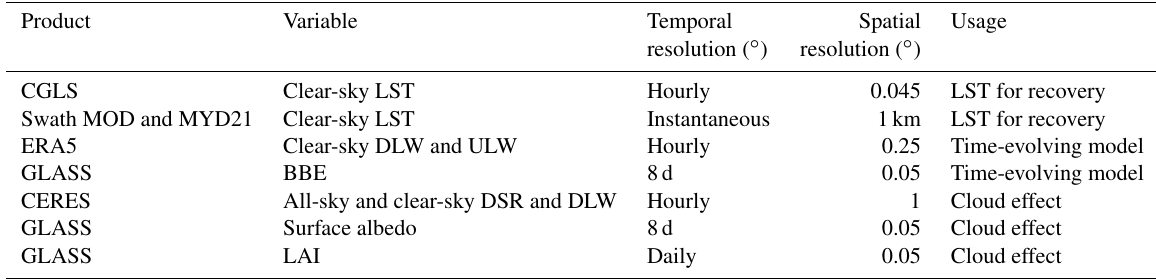
Table 2. Metadata input for production. Product Variable Temporal Spatial Usage resolution ( ◦ ) resolution ( ◦ ) CGLS Clear-sky LST Hourly 0.045 LST for recovery Swath MOD and MYD21 Clear-sky LST Instantaneous 1km LST for recovery ERA5 Clear-sky DLW and ULW Hourly 0.25 Time-evolving model GLASS BBE 8d 0.05 Time-evolving model CERES All-sky and clear-sky DSR and DLW Hourly Cloud effect GLASS Surface albedo 8d 0.05 Cloud effect GLASS LAI Daily 0.05 Cloud